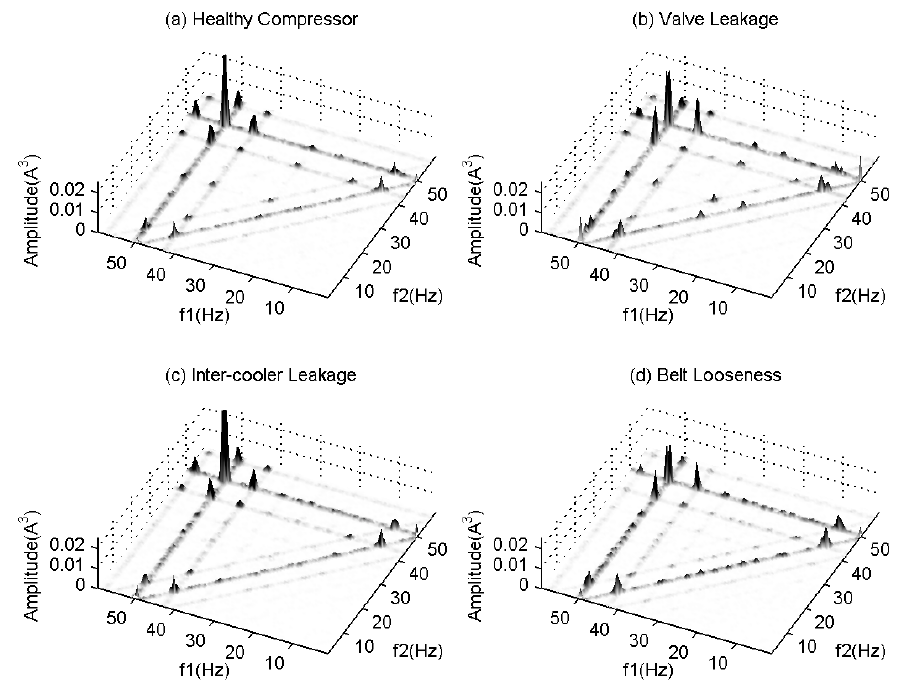
Figure 14. CB coherences for different conditions of the reciprocating compressor.